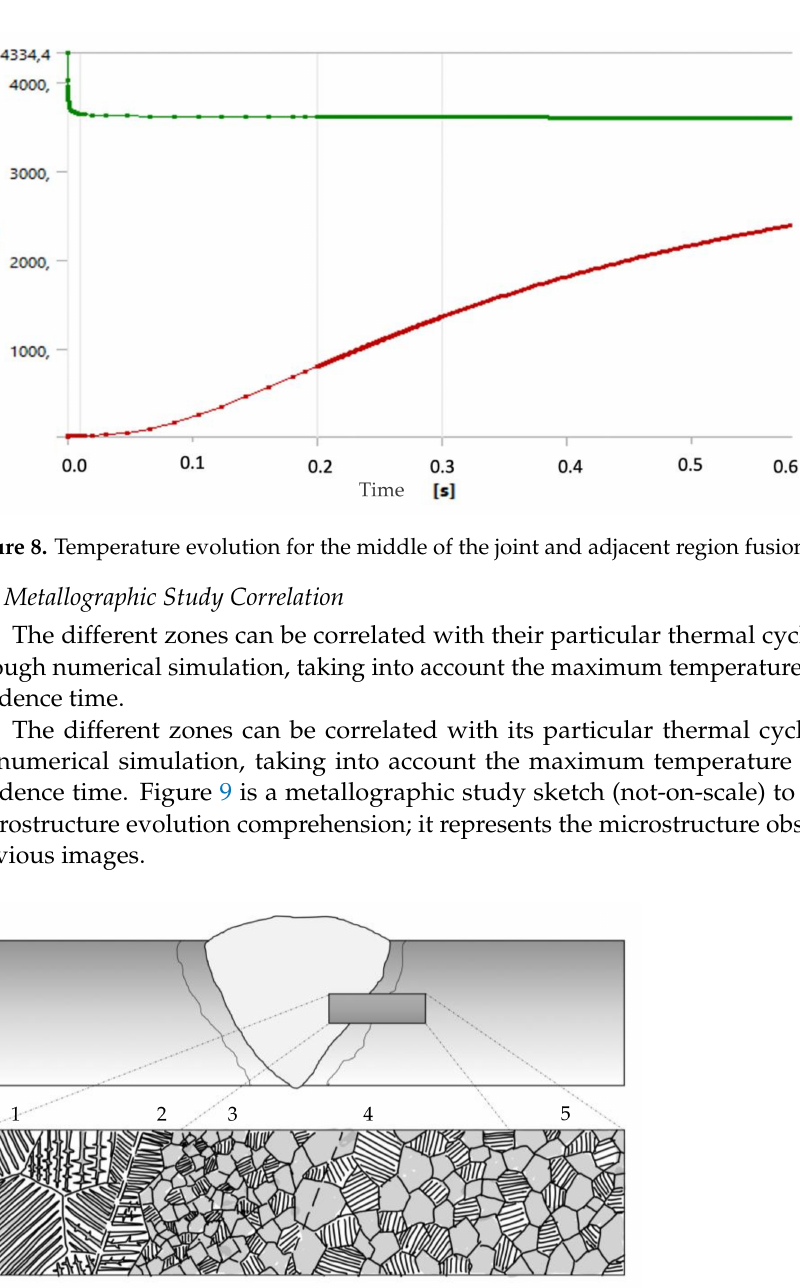
Figure 9. Metallographic study sketch